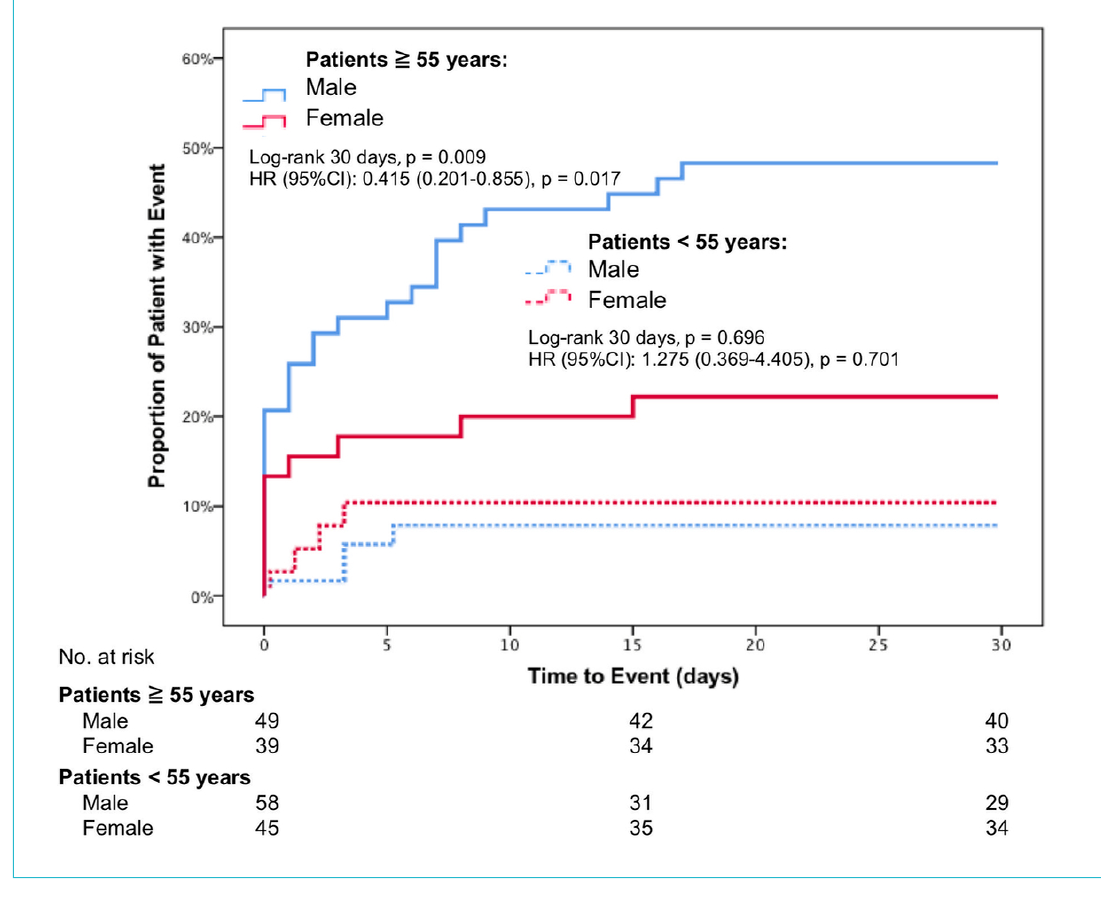
Figure 2: Composite outcome of admission to ICU, rehospitalization for respiratory complication and death within 30 days in SARS-CoV-2 positive patients under and over the age of 55 years.